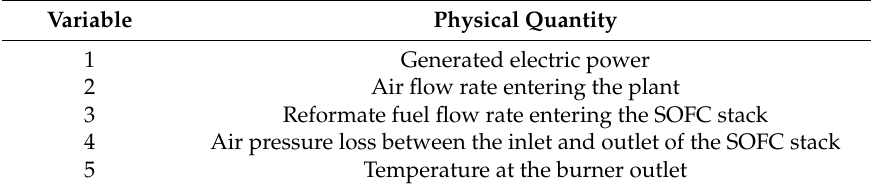
Table 1. Monitored variables used for the FDI in the considered SOFC